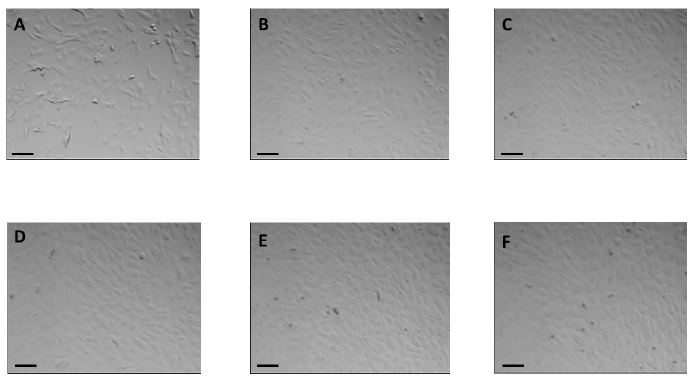
Fig 4. On-line microscopy of endothelial cells cultured in the ENDOXY system during the first 36 hours. Scale bar = 100 μ m.